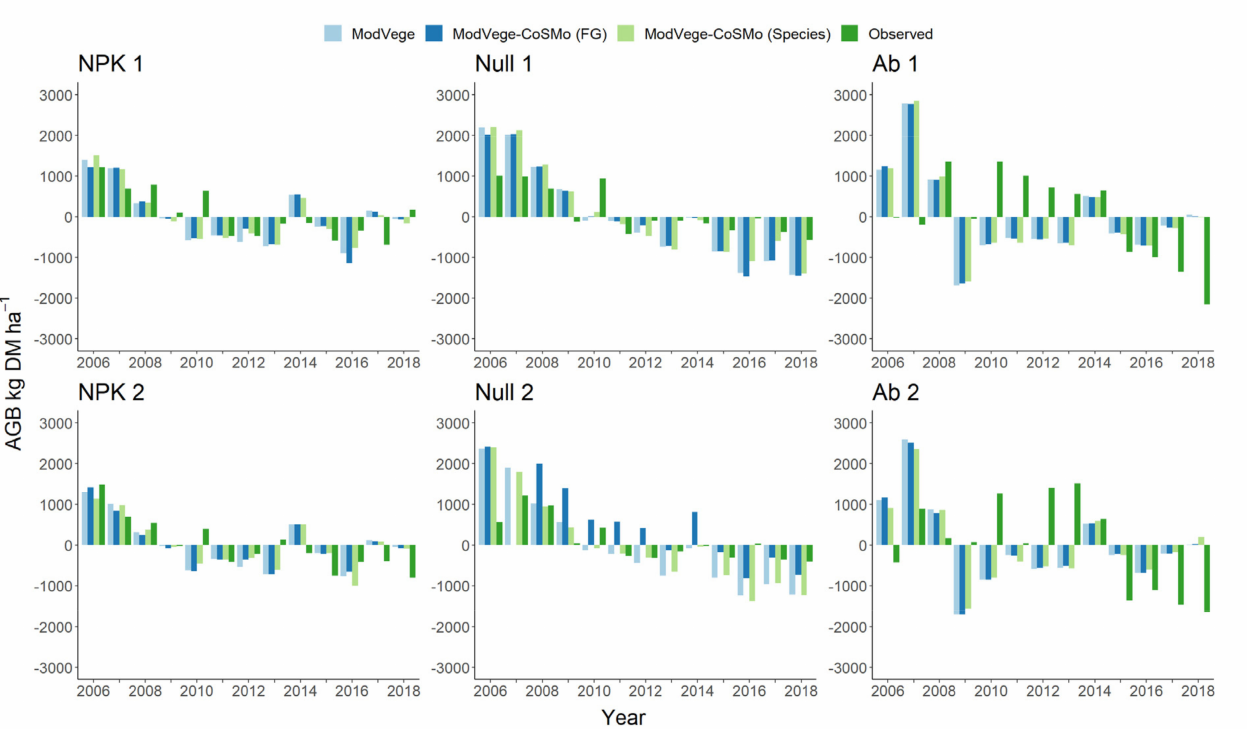
Figure 2. Annual anomalies of aboveground biomass (AGB), observed and simulated with alternative modelling solutions in three treatments (NPK: fertilised; Null: unfertilised; Ab: abandoned) and two blocks (1, 2). Annual mean values of AGB: NPK 1: 2895 kg DM ha − 1 ; NPK 2: 2477 kg DM ha − 1 ;